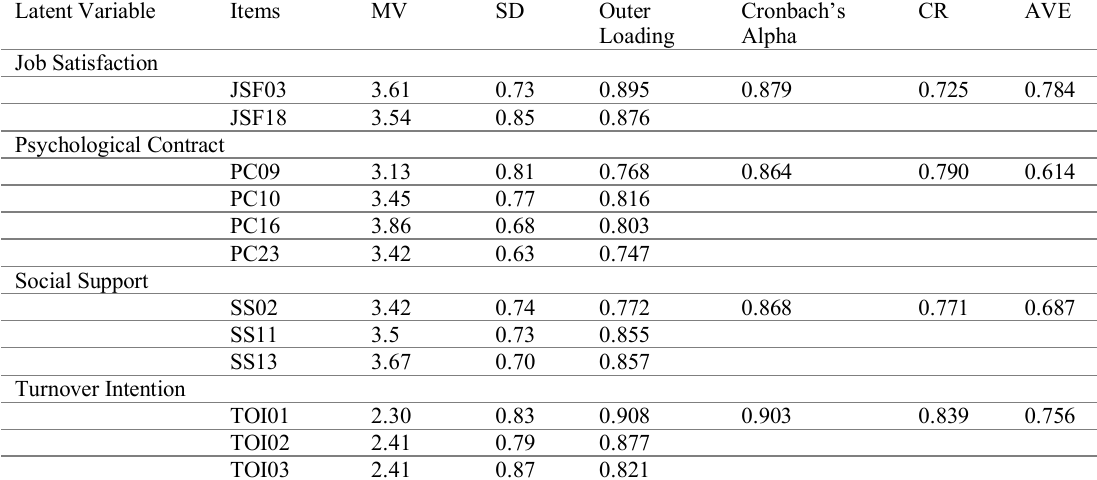
Table 3: Result of measurement